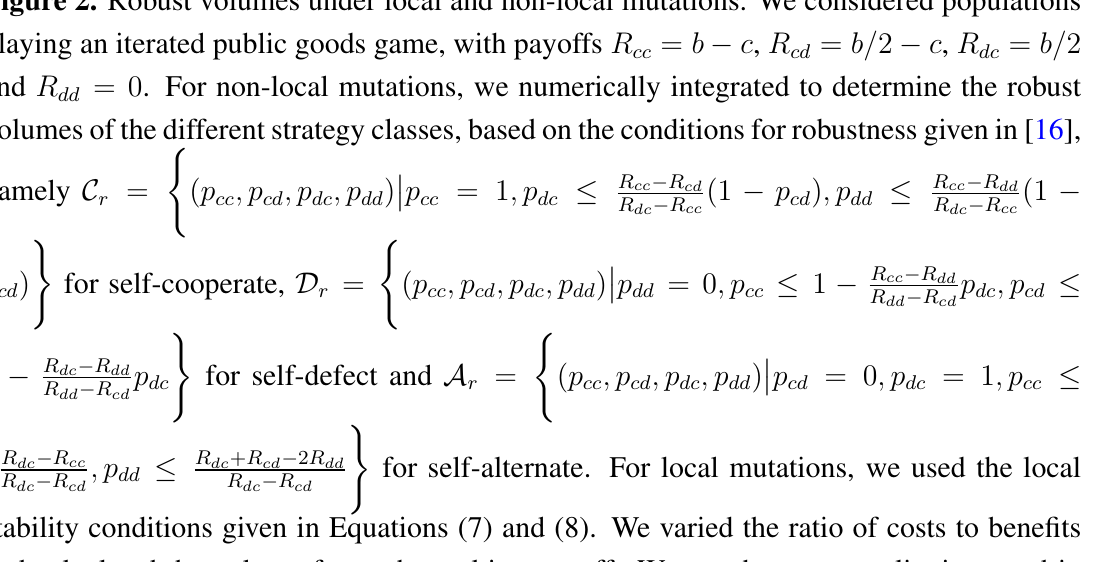
for self-alternate. For local mutations, we used the local stability conditions given in Equations (7) and (8). We varied the ratio of costs to benefits and calculated the volume for each resulting payoff. We see the same qualitative trend in both cases; however, the volume of robust self-defecting strategies is greater in the non-local compared to the local